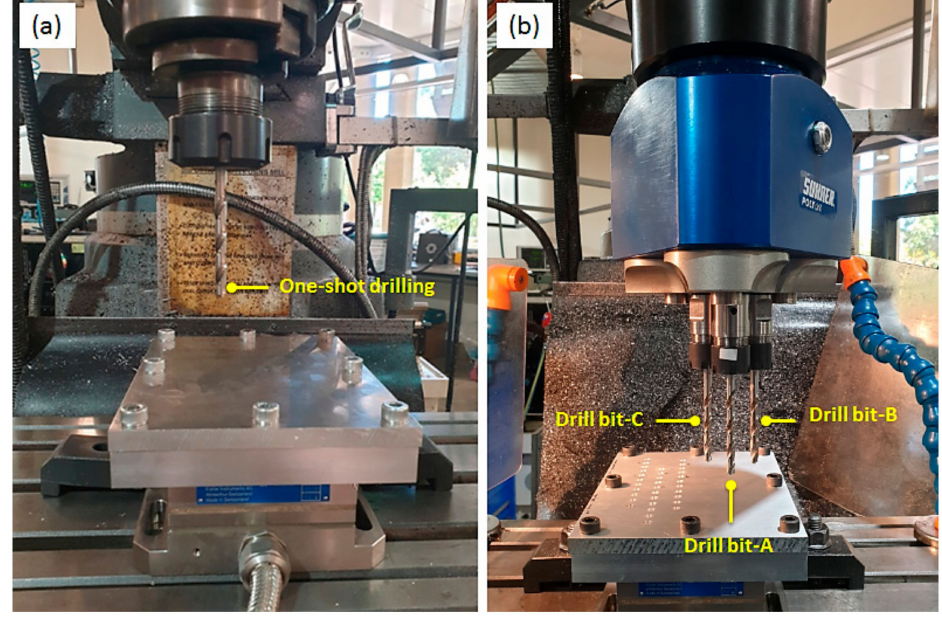
Figure 2. Setup of ( a ) one-shot drilling and ( b ) multi-spindle simultaneous drilling using a poly-drill head.